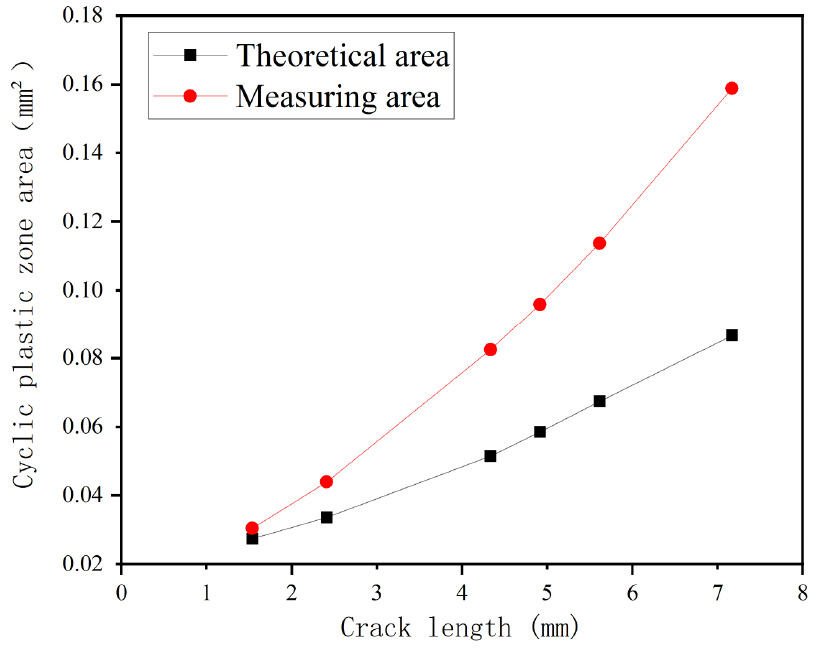
Figure 19. Comparison of theoretical area and measured area of cyclic plastic zone.